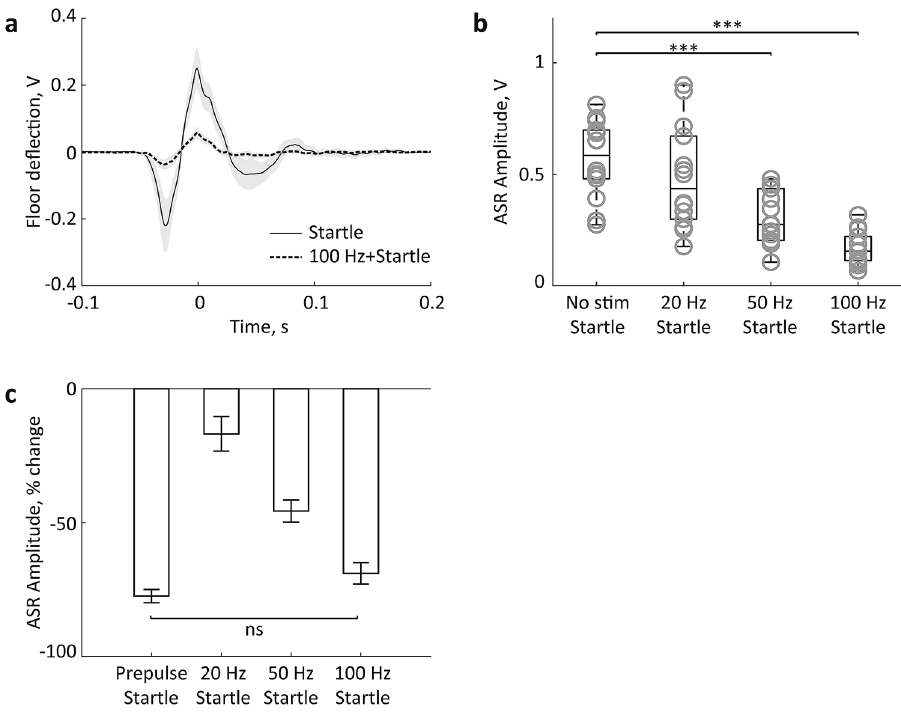
Figure 2. Priming LC stimulation attenuates the acoustic startle response. ( a ) The deflection shape of a movement-sensitive floor. Data from a representative session are shown. Traces are aligned to the maximal amplitude (t = 0) and averaged over the startle only trials (n = 40 trials) and the startle preceded by LC stimulation (n = 40 trials, 0.05 mA, 100 ms at 100 Hz); shadows show s.e.m. ( b ) The ASR amplitude elicited by the startle alone and the startle followed by LC stimulation at different frequencies. Box-whisker plots show the median, the first and third quartiles, min/max. Circles represent session averages. ( c ) The ASR amplitude change for different trial types. Note, the LC stimulation at 100 Hz mimicked the auditory prepulse. ***p < 0.001 (post hoc comparisons, Bonferroni corrected).